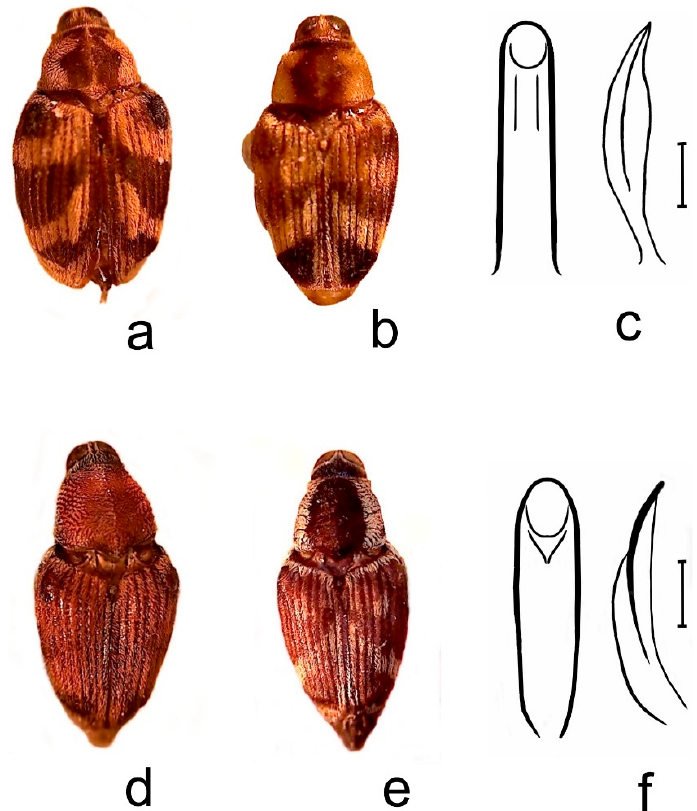
Figure 10. ( a ) Philenis ferruginea , dorsal habitus; ( b ) P. guyanensis , dorsal habitus; ( c ) P. guyanensis, male genitalia, dorsal and lateral views; ( d ) P. howdeni , dorsal habitus; ( e ) P. kuscheli , dorsal habitus; ( f ) P. kuscheli , male genitalia, dorsal and lateral views; scale bars = 0.2 mm. Head 0.95 mm wide, 0.55 mm long, very convex in dorsal view, eyes narrowly separated by 2 rows Specimens examined : Holotype: French Guiana: Nouragues Saut-Parar é , 4 ◦ 02 (cid:48) 16.1 (cid:48)(cid:48) N, 52 ◦ 40 (cid:48) 21.1 (cid:48)(cid:48) W, 09.2009, S. Brul é , Window trap (BMNH(E) 2010-62). Paratypes: Same data as